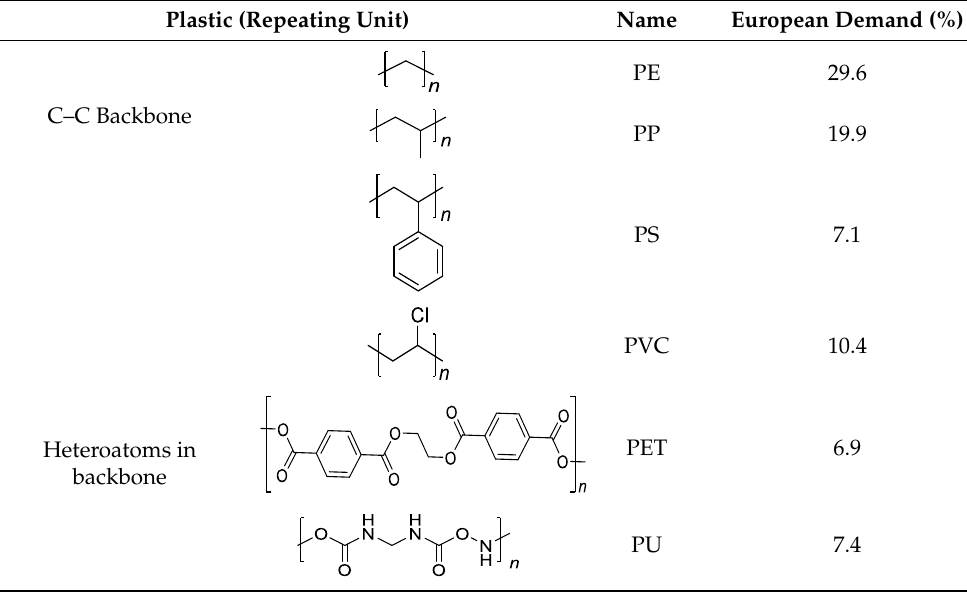
Table 1. The most common plastics and their European demand [10].